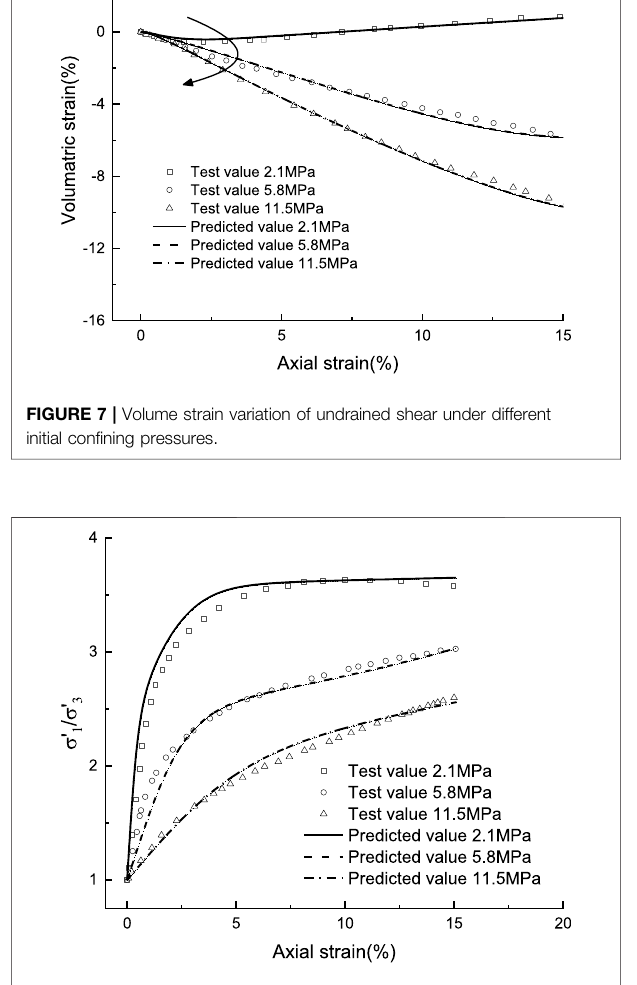
Frontiers in Earth Science |